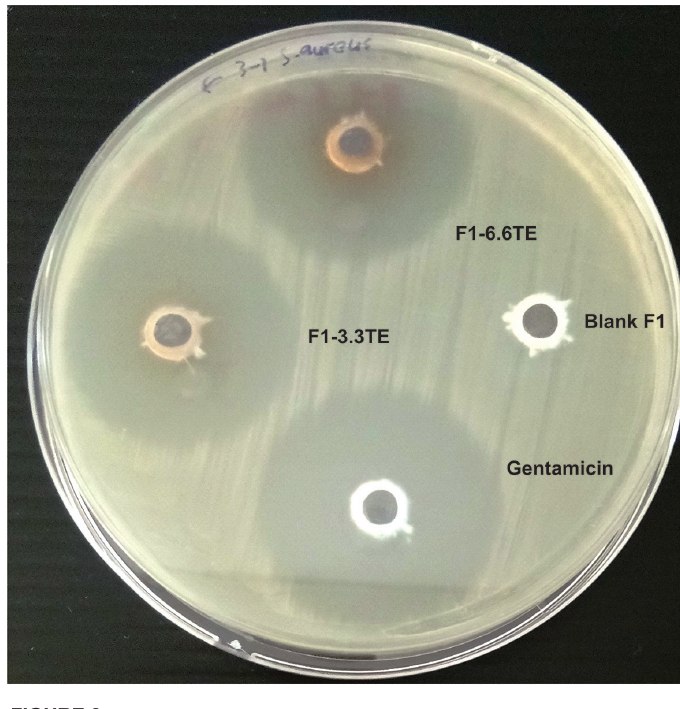
FIGURE 3 - Zone of inhibition (mm) of S. aureus from samples, negative and positive controls. TABLE VIII - Antibacterial activity of tamarind extract loaded nanoemulsions against S. aureus and S. epidermidis